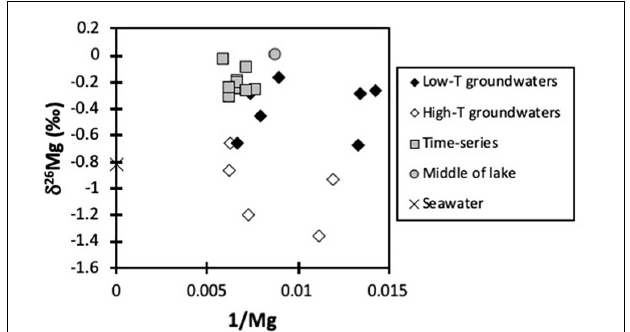
FIGURE 2 | Mixing diagram [1/Mg (in µ mol/l) vs. δ 26 Mg] for the groundwaters, outflow time series, and seawater (representing Icelandic precipitation). No mixing trends are visible.